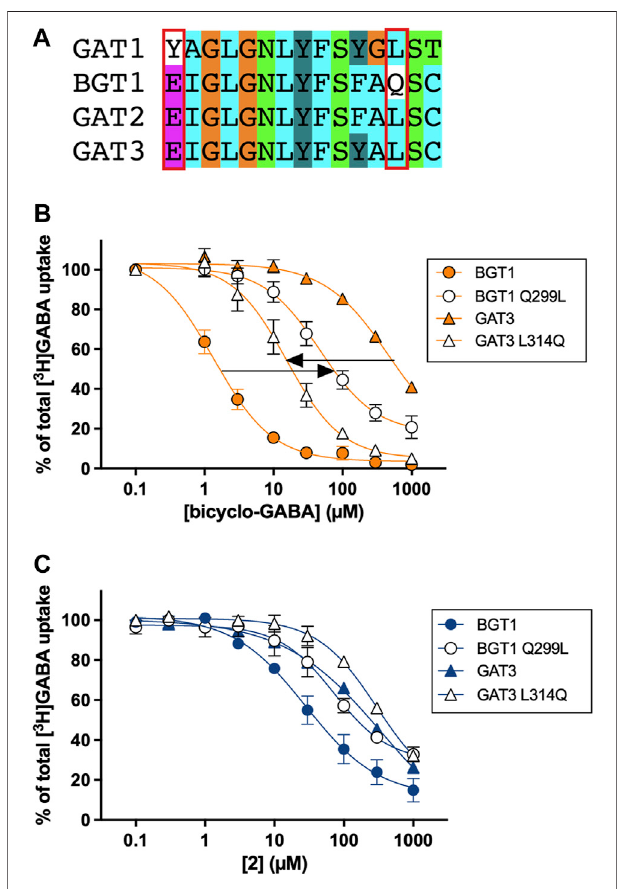
FIGURE 6 | (A) Pocket alignment of the orthosteric site of the four GAT subtypescoloredaccordingtothedefault ClustalX colorscheme(Larkinetal., 2007).The pocket wasde fi ned as all correspondingGAT residues (15 in total) that are within a distance of 4.5 (cid:1) A of the co-crystallized ligand leucine in thehomologousLeuTcrystal structure (PDBID2A65)(Yamashita et al.,2005) according to the alignment by Kickinger et al. (Kickinger et al., 2019). The mutated residues in BGT1 and the corresponding residues in GAT1-3 are indicated by a red box. The numbering of all residues within the orthosteric pocket can be found in the Supplementary Table S1 . [ 3 H]GABA uptake concentration-response curves of (B) bicyclo-GABA and (C) 2 at BGT1 (wt), BGT1 Q299L, GAT3 (wt) and GAT3 L314Q transiently expressed in tsA201 cells (human subtypes). Pooled data (n (cid:1) 3 – 4) based on technical triplicates, normalized to 100% [ 3 H]GABA uptake (presented as means ± S.E.M). The IC 50 and pIC 50 values are presented in Table 2